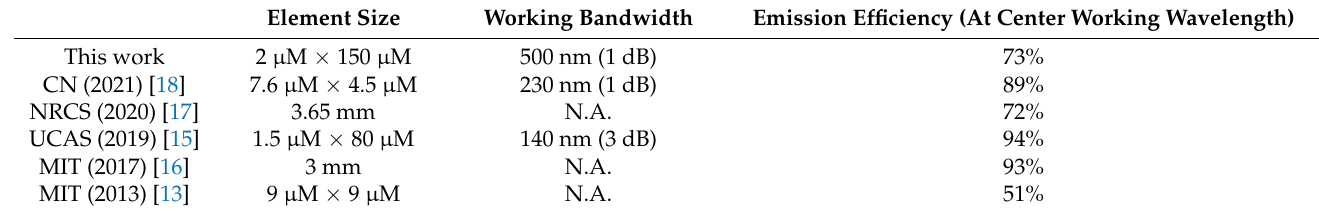
Table 2. Performance comparison table for optical